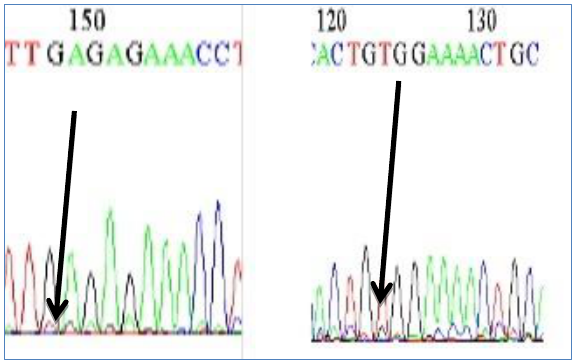
Figure, 4: Nucleotide sequence of genotype of exon2 GnRHR gene. The right arrow is a G/A heterozygote, and the left arrow is a G/T